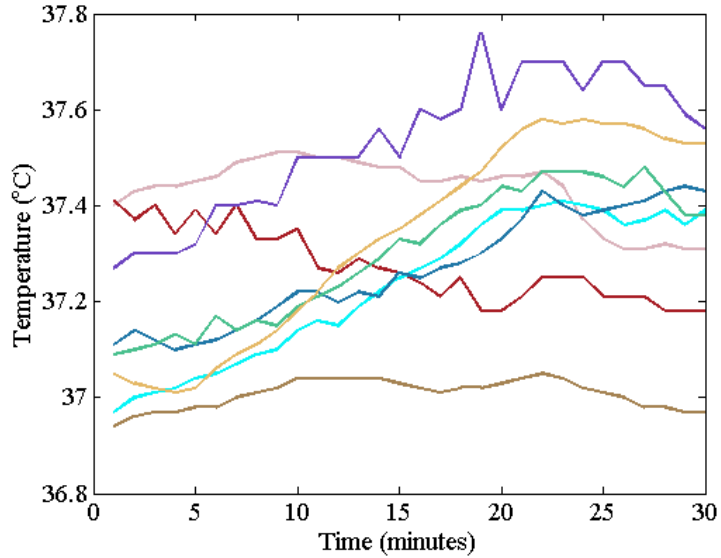
Figure 9. DBT measured on the forehead of eight subjects (each color represents an individual).